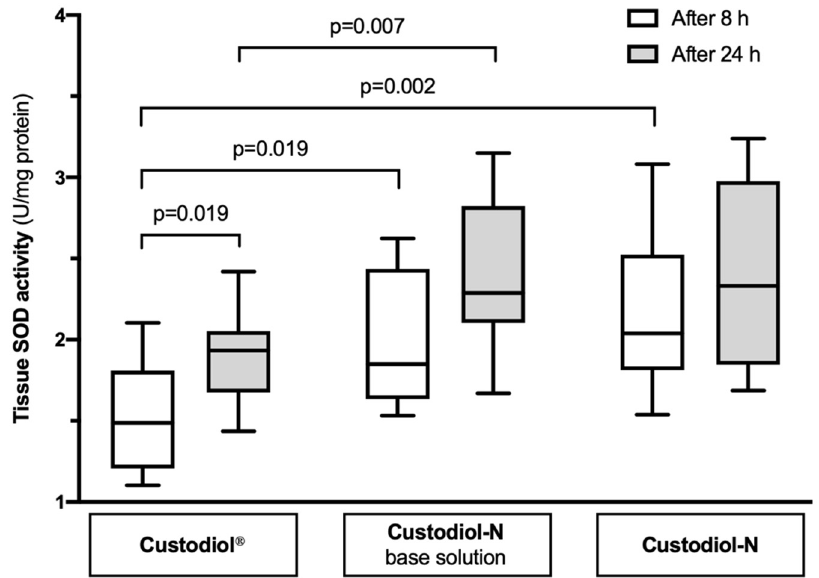
Figure 3. The SOD activity in uterus tissue samples preserved in di ff erent solutions for 8 and 24 h.